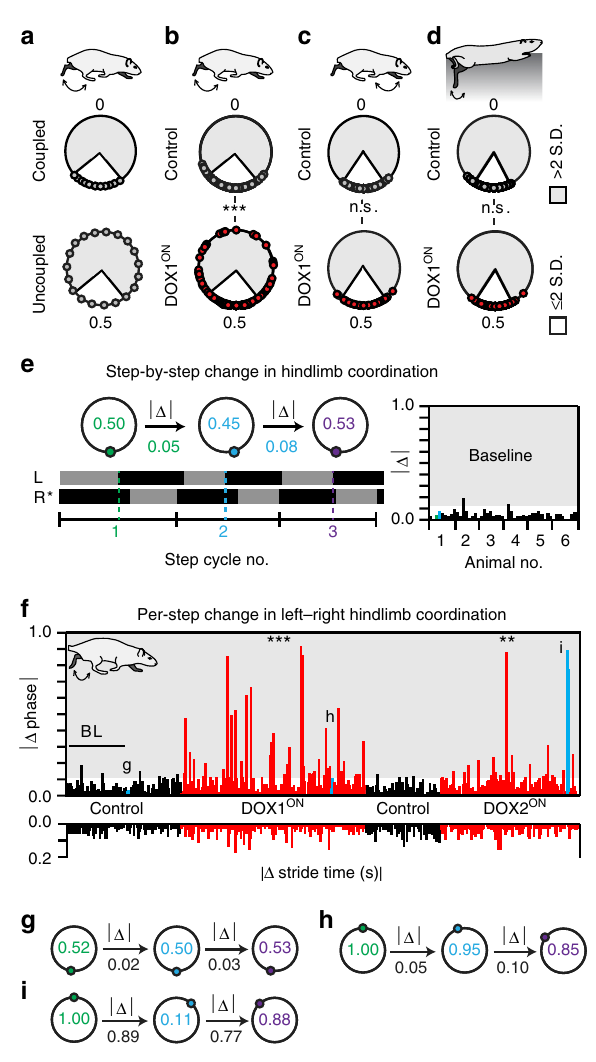
Fig. 5 Silencing L2 – L5 interneurons partially uncouples the hindlimbs, signi fi cantly increasing the step-by-step variability in left – right coordination. a Coupling and complete uncoupling schematics (white inset = normal variability observed at control time points). b Silencing L2 – L5 interneurons signi fi cantly decreased phases concentrated at alternation during hindlimb stepping as compared to Control (Baseline + Pre-DOX1 vs. DOX1 ON D3,5,8; *** p < 0.001; U 2 = 0.59762; Watson ’ s U 2 test, n = 84 step/time point). c Forelimb stepping ( U 2 = 0.004403) and d hindlimb swimming ( U 2 = − 2.8665; n = 80 stroke cycles/time point) remained clustered at alternation (see Supplementary Tables 3, 4). e Example of swing – stance graph illustrating analysis of consecutive strides within one locomotor bout to determine the step-by-step (absolute) change in left – right coordination (*denotes reference limb for one complete stride cycle). Individual bars represent change in left – right coordination, per step, for each animal across all time points (right panel, e.g., Baseline, absolute change in coordination between steps 1 to 2 and 2 to 3 highlighted in green and blue, respectively). Shaded region indicates per-step changes in coordination beyond control variability. f (top panel) Silencing L2 – L5 interneurons signi fi cantly increased step-by-step variability in hindlimb coordination (Baseline+Pre-DOX1 vs. DOX1 ON , n = 3/80 vs. 38/136 ( p < 0.001, z = 5.5); DOX OFF +Pre-DOX2 vs. DOX2 ON , n = 2/53 vs. 21/100 ( p = 0.00039, z = 3.56); ** p < 0.01, *** p < 0.001, B.P. test). Select examples of per-step changes in left – right coordination (vertical bars highlighted in blue) are emphasized in g – i below. The hindlimbs stepped with relatively consistent stride durations (bottom panel). Illustrations by A.